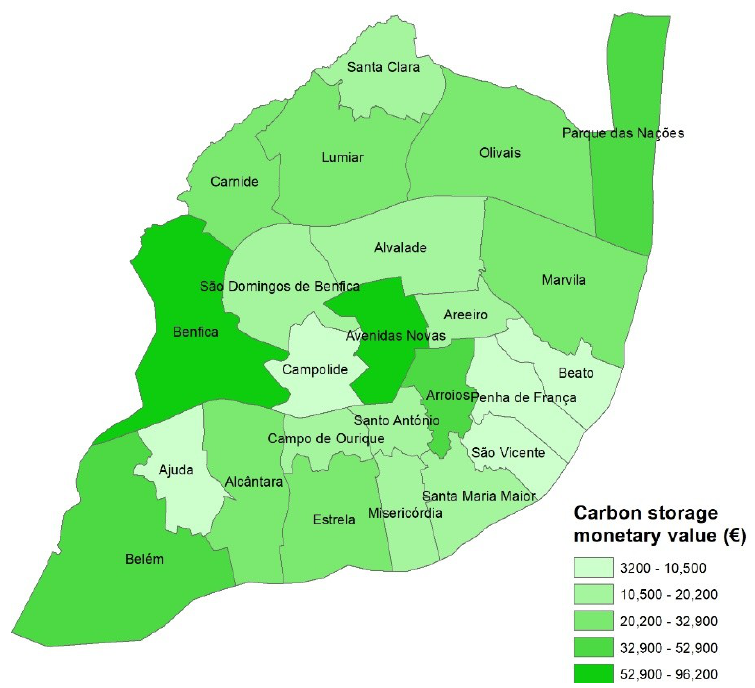
Figure 8. Carbon monetary value of carbon stored in each parish, by the seven most represented tree species in the city of Lisbon.